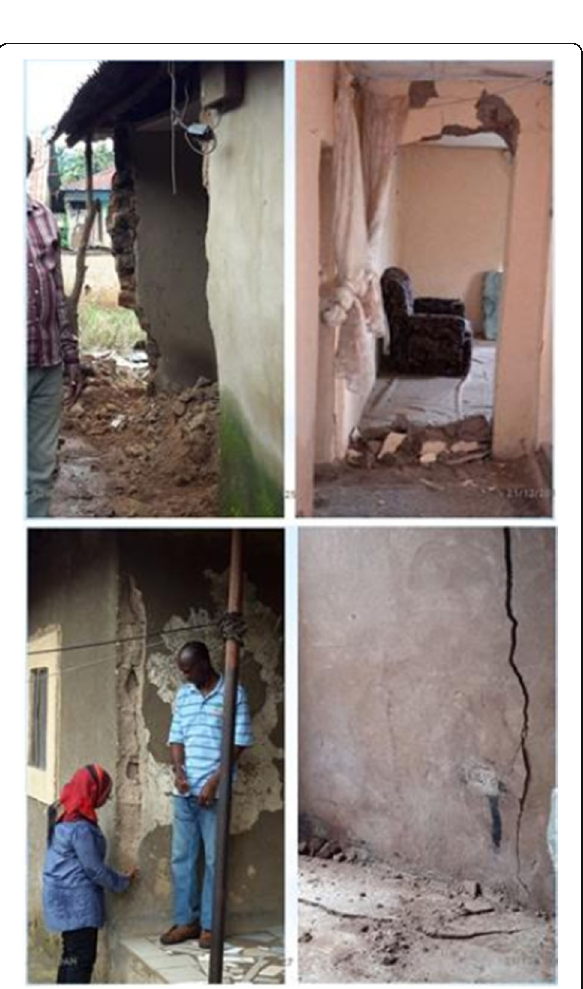
Fig. 6 Field photographs of some of the impacted building during the tremor of 17/09/2016. Door lintels, wall sections and very vissble cracks show evidences of